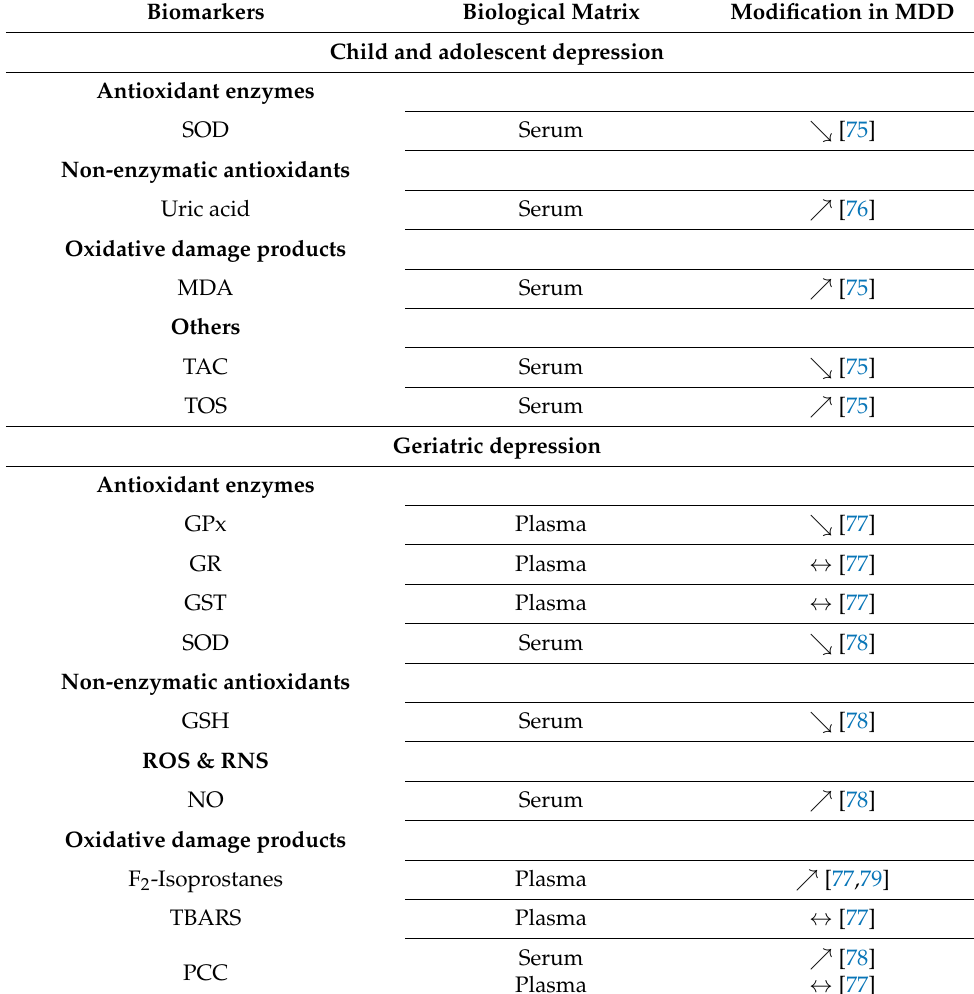
Table 7. Peripheral biomarkers of oxidative stress in MDD patients according to the disorder on- set compared to healthy controls. MDD: Major depressive disorder—GPx: Glutathion Peroxydase— GR: Glutathion Reductase—GST: Glutathion-S-Transferase—SOD: Superoxide dismutase